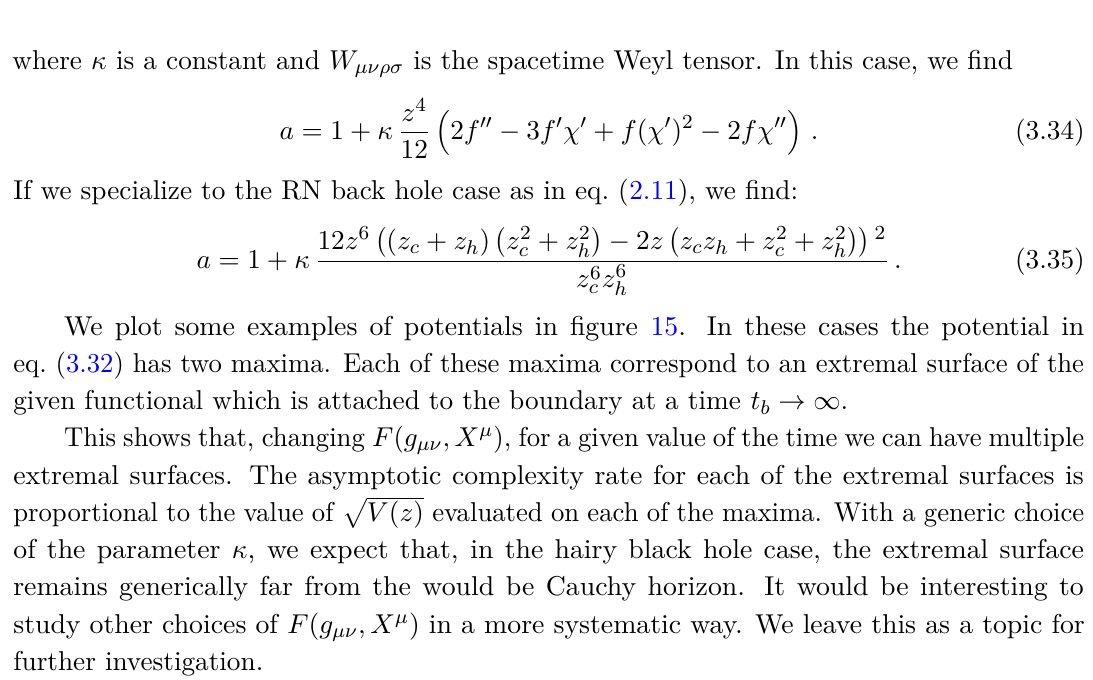
Figure 15 . Examples of potentials V ( z ) the RN black solution for with z h = 1 , z c = 5 . In the black curve, we choose the volume functional, i.e. F = 1 . In the blue and red curves, we choose the functional in eq. (3.33) with κ = 0 . 0003 and κ = 0 . 003 ,